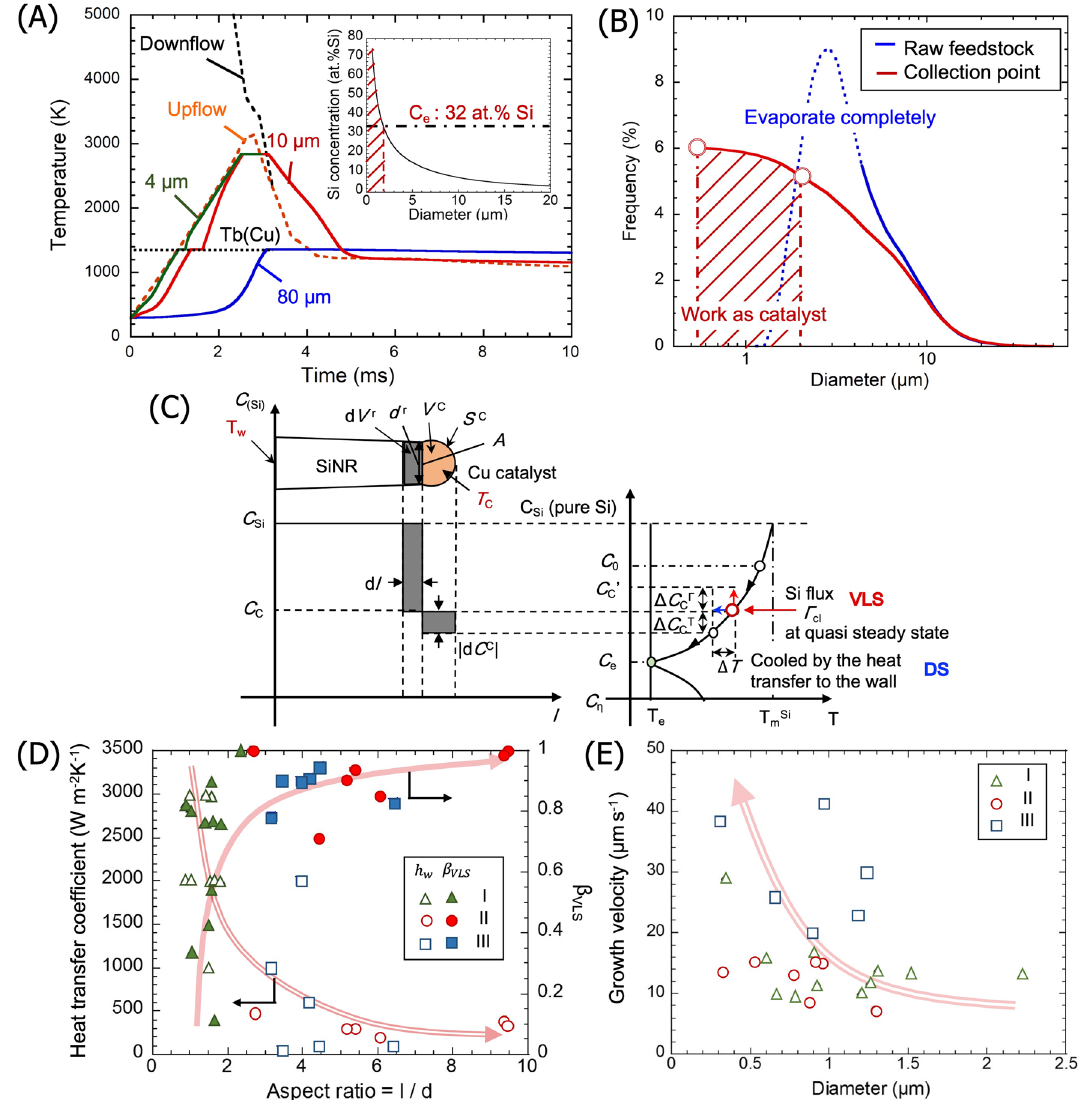
Figure 3. ( A ) Heating histories of Cu particles with different initial diameters. The inset is the Si concentration in the Cu droplets at the collection point. ( B ) Size distribution of the initial Cu particles and of the molten catalyst for DS mode. ( C ) Schematic representation of the mass transfer during nanorod growth, showing the Si redistribution at the growth interface (left) and the corresponding concentration in the Si–Cu binary phase diagram (right). ( D ) Relationship between the aspect ratio of the nanorods and the heat transfer coefficient and the VLS contribution. ( E ) The total growth velocity of nanorods as a function of rod